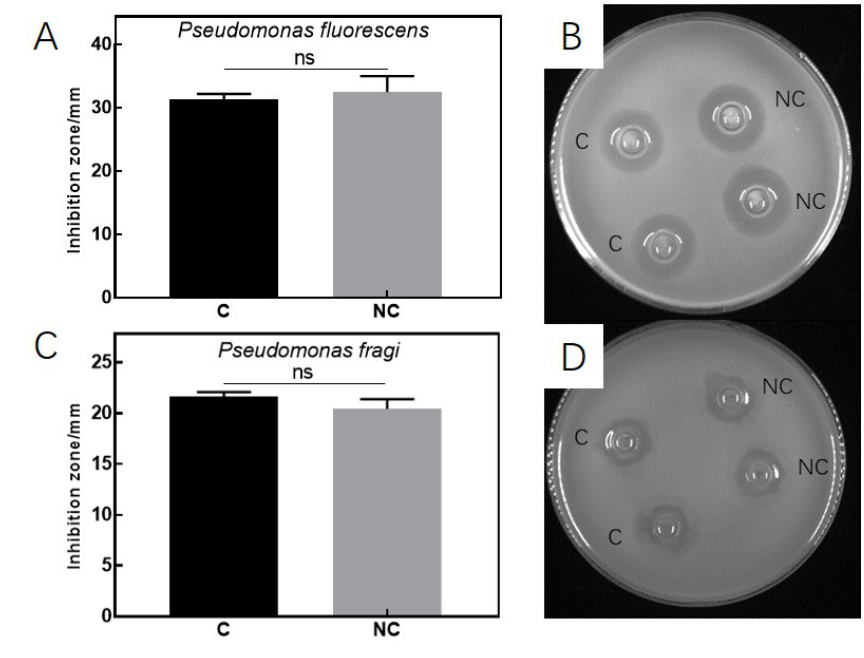
Figure 1. Antibacterial effects of D. algida against the target Pseudomonas , where ( A , B ) are the diameter and appearance, respectively, of the produced inhibition zone of P. fluorescens , and ( C , D ) are the diameter and appearance, respectively, of the produced inhibition zone of P. fragi . The data are shown as mean ± SD ( n =